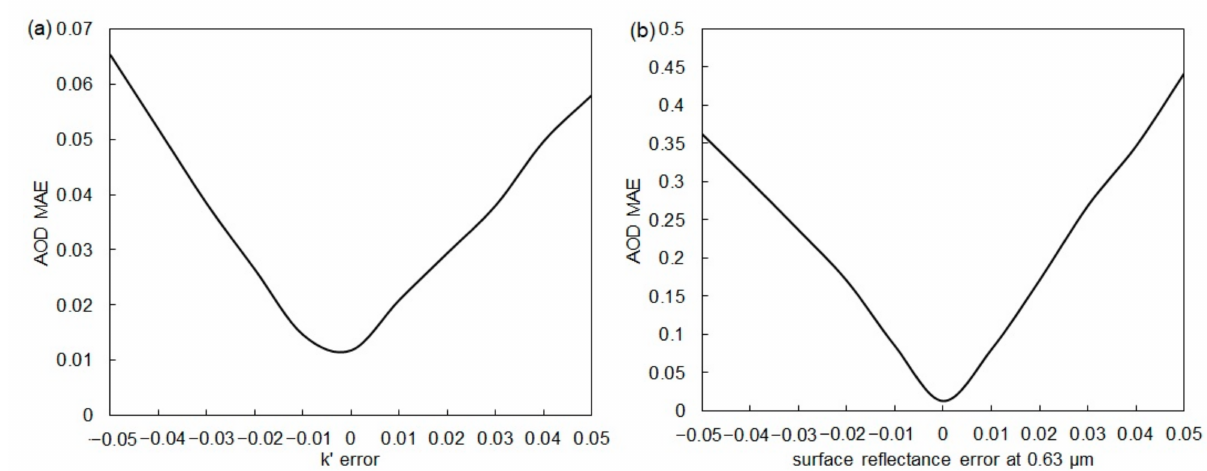
Figure 6. The AOD MAE versus the 𝑘′ error ( a ) and the surface reflectance error at 0.63 μ m ( b ). The effect of the 𝑘′ ratio error on the discrimination of the TOA reflectance ratios was also investigated. The sun-view angles and the surface reflectance values at 0.85 μ m were taken the same values as Figures 4 and 5. The error of ±0.05 and ±0.1 was added to the 𝑘′ value (depicted in Figures 7 and 8, respectively). It is shown that for 𝑘′ = 0.845 the error of ±0.05 would cause the TOA reflectance ratio indistinguishable, while for 𝑘′ = 0.1177 the condition varies with the AOD value. When the AOD value is less than 1, the error of ±0.05 would cause the TOA reflectance ratio difficult to be distinguished (Figure 7). When the AOD value is larger than 1, the error of the 𝑘′ value causing the TOA reflectance ratio indistinguishable would be 0.1 (Figure 8).